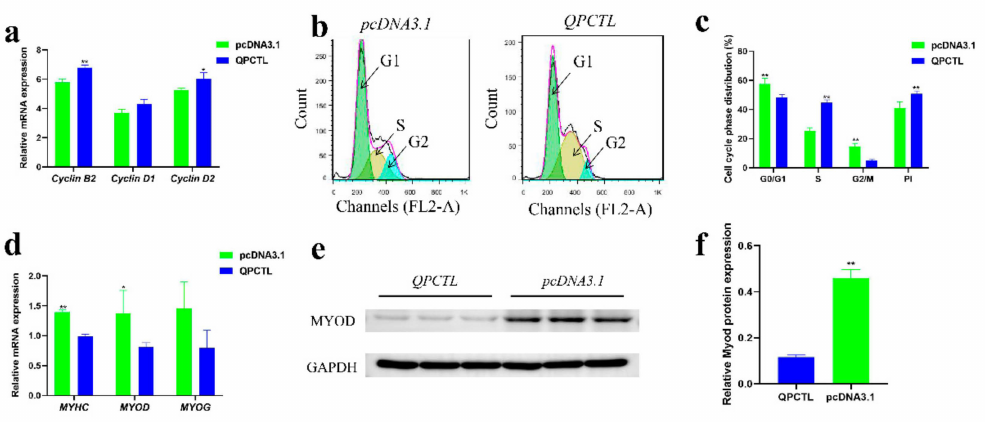
Figure 6. QPCTL promotes the proliferation of CPMs and inhibits their differentiation. ( a ) Expression of cell cycle-related genes after the overexpression of QPCTL . ( b , c ) Cell cycle analysis of QPCTL overexpression in CPMs. Count represents the number of cells counted; FL2-A is the propidium iodide fluorescence area signal, representing the DNA content of cells. The result of ( c ) comes from ( b ). ( d ) Expression of myoblast differentiation-related genes after the overexpression of QPCTL . ( e , f ) Protein level of MYOD in differentiated myoblasts transfected with the QPCTL overexpression vector. * p < 0.05; ** p <